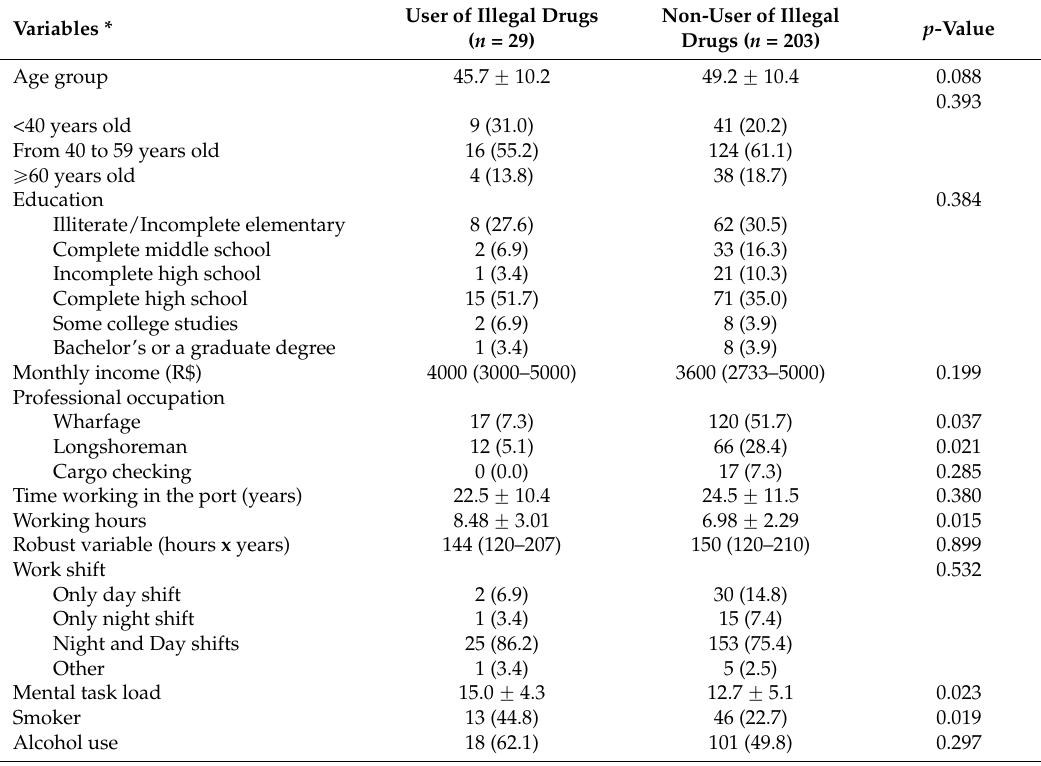
Table 2. Bivariate analysis of illegal drugs with sociodemographic, occupational and personal variables of dockworkers in the interior of Rio Grande do Sul,